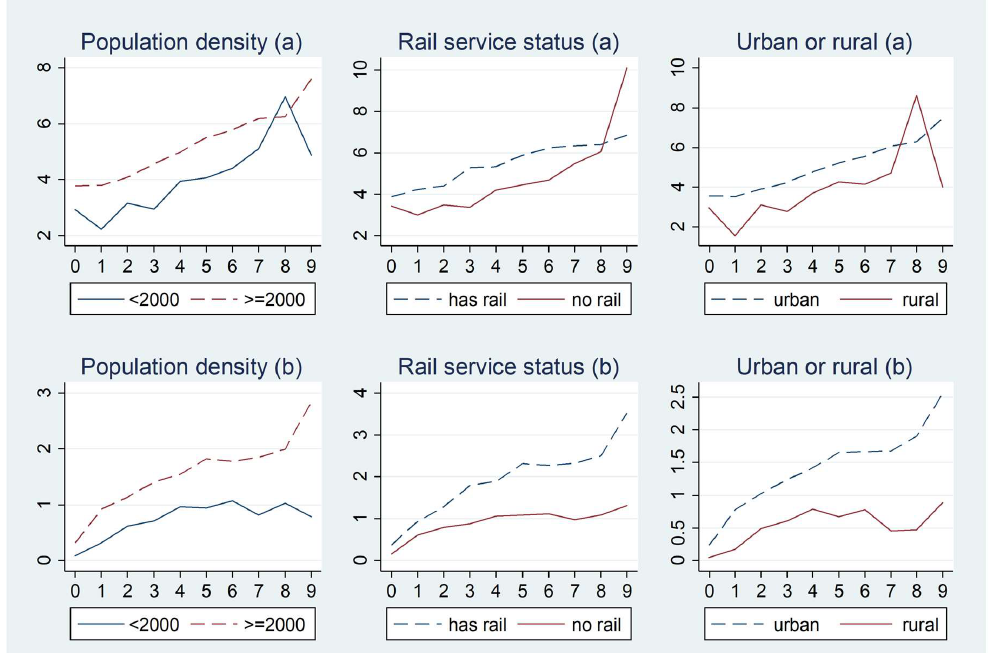
Figure 5. Relationship between ridesharing and public transit use varying by household characteristics for those who use ridesharing in the past 30 days: ( a ) 1–99 times; ( b ) 0–99 times.